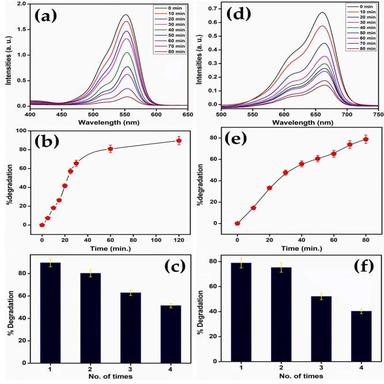
Time-dependent UV–Vis Absorbance spectrum indicating the degradation of (a) Rh–B and (d) MB dye by SCD5 catalyst. Variation of % degradation of (b) Rh–B and (e) MB as a function of time. Reusability of SCD5 catalyst on (c) Rh–B and (f) MB dyes.